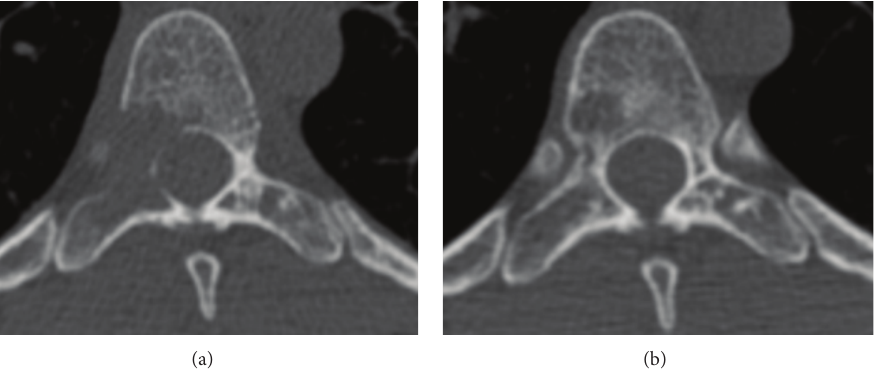
Figure 2: (a) Computed tomography of the spine showed a large solitary osteolytic lesion of thoracic number 8 vertebral body and right pedicle. (b) Repeat CT spine, 18 months later, showed evidence of significance bone regeneration at the T8 osteolytic